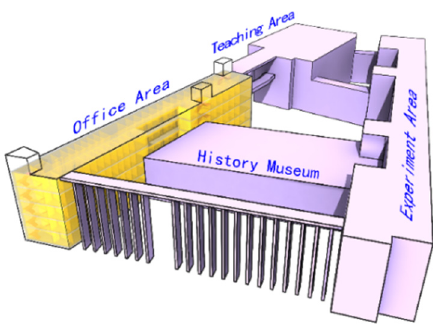
Figure 3. 4th teaching building on the Xipu campus of Southwest Jiaotong University.